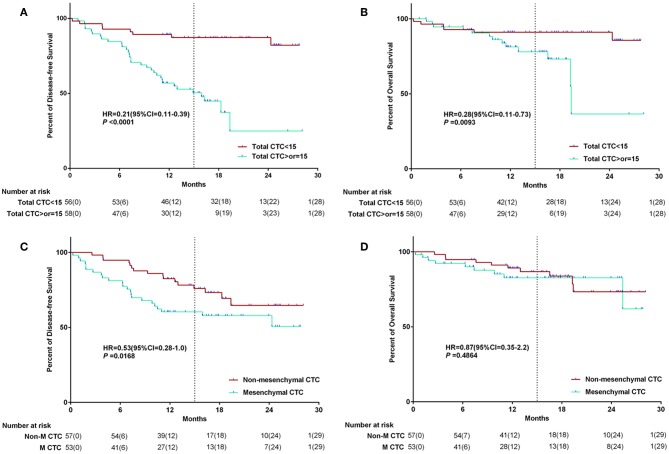
The Kaplan–Meier survival curve of CTC number and MCTC number association with survival. The relationship between CTC quantity and survival (A,B); The relationship between CTC subtype and survival (C,D).